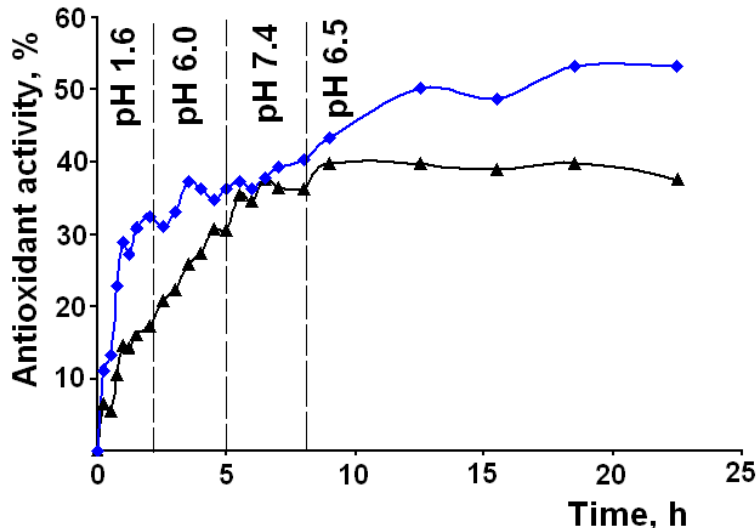
Figure 5. Experimental kinetic curves of antioxidant activity of the released LA (black line) and LM (blue line) from LA–MMS (pH 7) and LM–MPMS (pH 7) composites upon changes in pH and residence time of the drugs in different segments of the GIT (results are average of triplicate experi- ments.